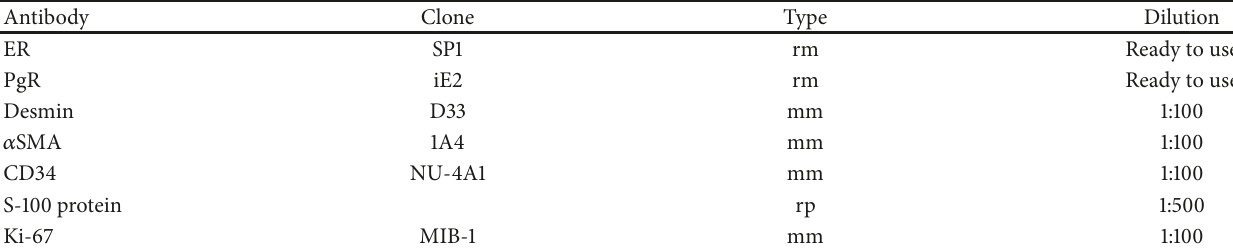
Table 1: Primary antibodies used in this study.